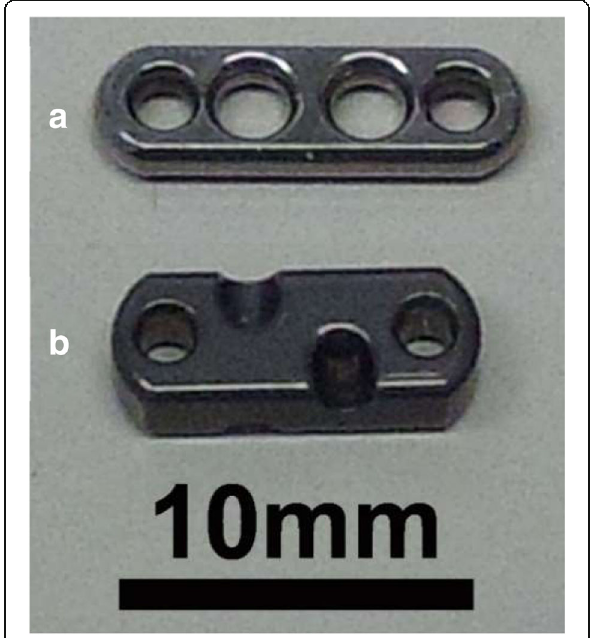
Fig. 1 Photograph of original ( a ) and improved ( b ) EndoButton. Our improved EndoButton holes are not perpendicular to the bone surface on which the button is placed, but have an angle of 45 degrees so that the button can be temporarily fixed by applying tension to the suture. The thickness of the improved EndoButton is 2.5 mm, 1.0 mm thicker than the original